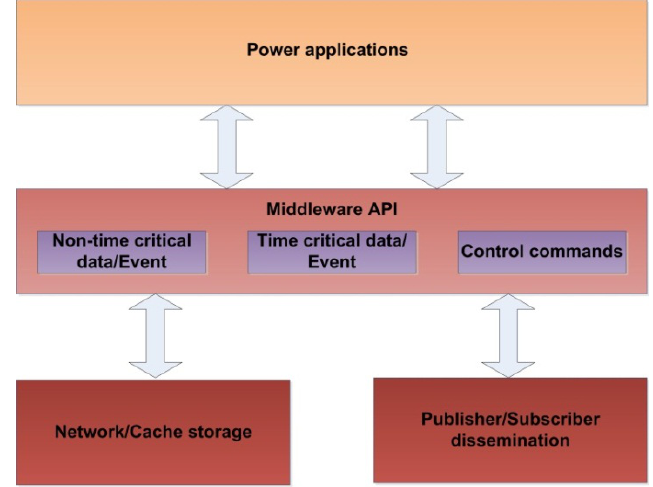
Figure 10. Secure Decentralized Data-Centric Information Infrastructure components, as described in